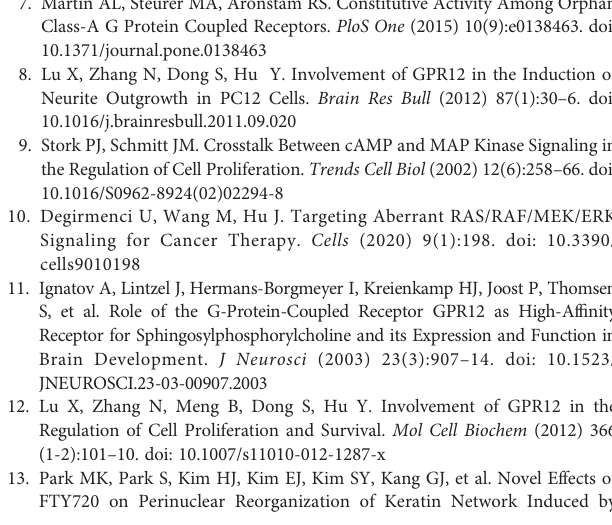
Supplementary Figure 2 | The mRNA level and survival analysis of GPR12 and mRNA level of E3 ubiquitination ligase targeting GPR12 in ovarian caner and other cancer types. (A) , mRNA level of GPR12 in tumor and normal tissues of 33 cancer types. (B) , Correlation of GPR12 expression with disease free survival (DFS) was evaluated using Kaplan – Meier analysis in the TCGA pancreatic adenocarcinoma (PAAD) patients. (C) , mRNA level of multiple E3 ubiquitination ligases in ovarian cancer (OV), glioblastoma multiforme (GBM) and brain lower grade glioma (LGG) by using TCGA database. Supplementary Figure 3 | Correlation analysis of GPR12 and ERK1/2 cascade in OV data from TCGA database. (A – D) , Correlation analysis of GPR12 mRNA level with ERK1/2 cascade expression including MAP3K1 (A) , MAP2K1 (B) , MAP2K2 (C) and MAPK1 (D) by analyzing OV data from TCGA database. Supplementary Table 1 | Primers used in the reactions for clone